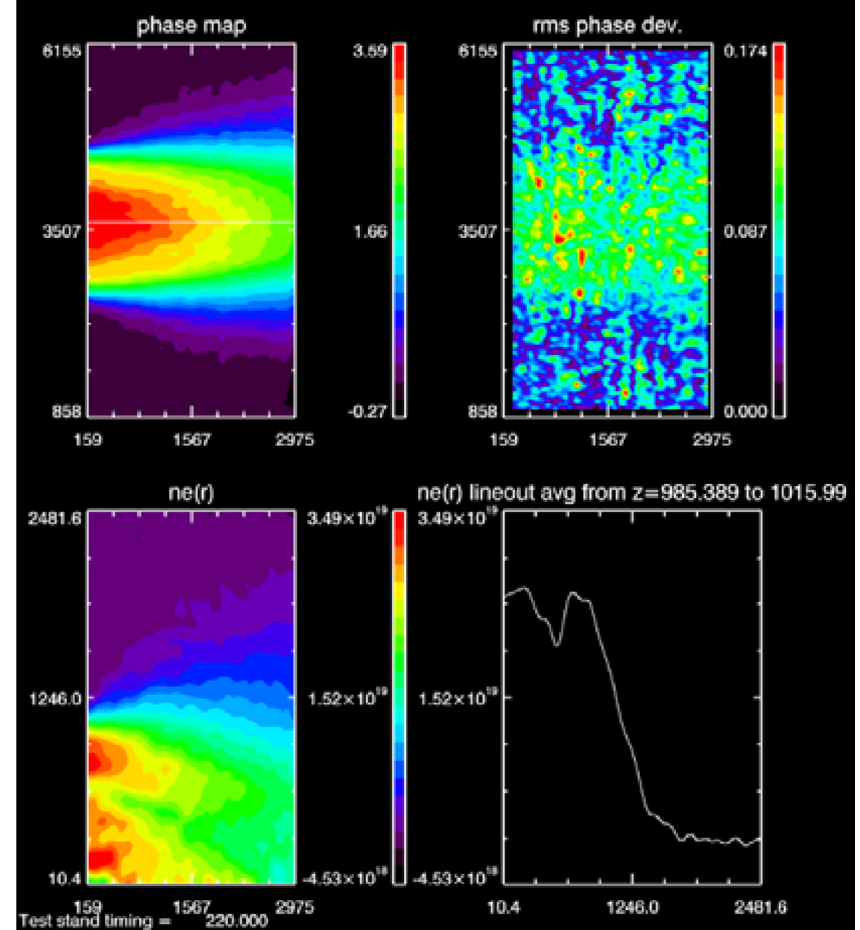
FIG. 17. Interferometer data from a He jet produced by the MOC nozzle at 615 psia = 500 V . Data snapshot at 220 (cid:1) s after valve is fired (gas flow is fully